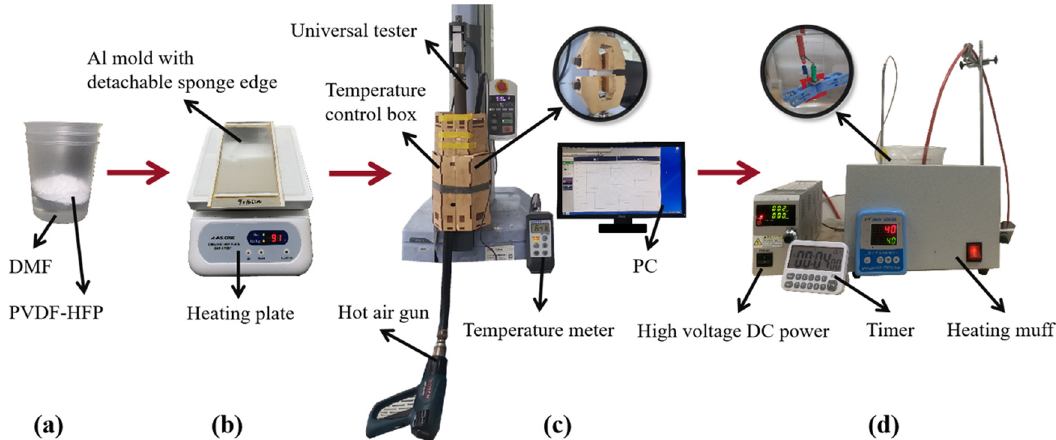
Figure 1: Preparation process of PVDF - HFP piezoelectric fi lms: ( a ) solution, ( b ) initial crystallization, ( c ) uniaxial stretching, and ( d ) step - wise poling.